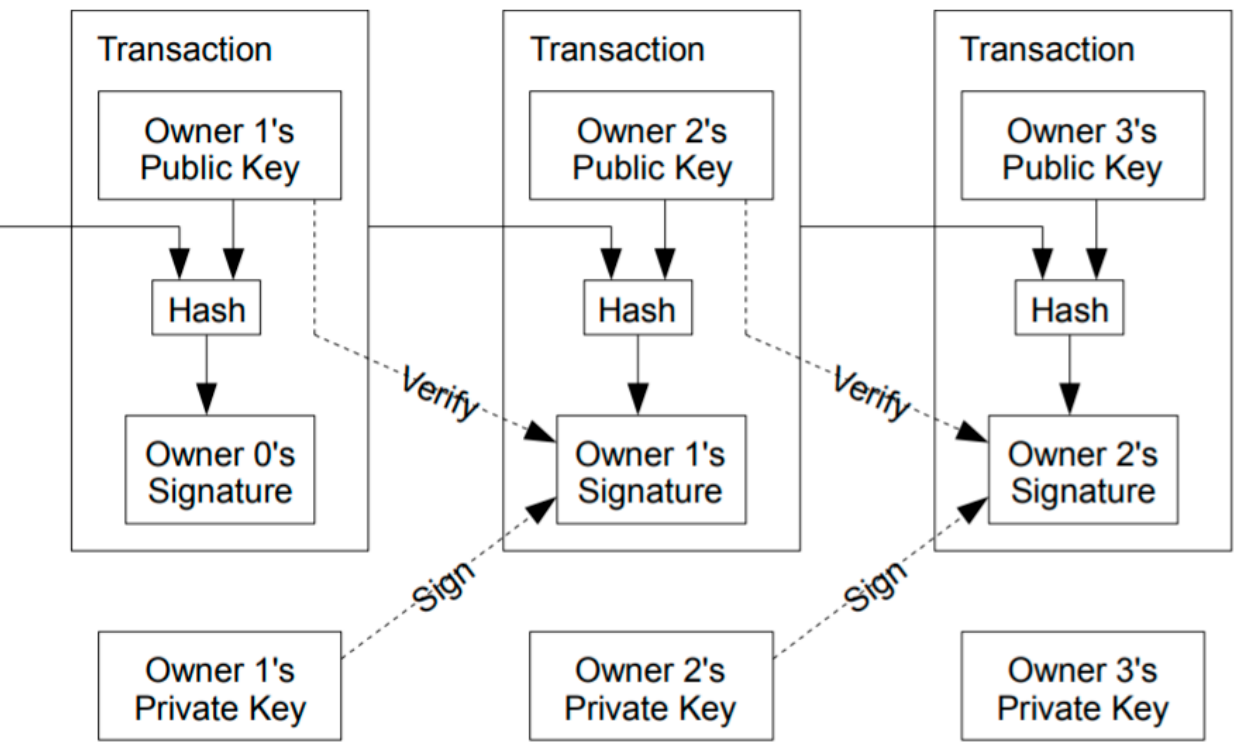
Figure 5. The Algorithm Structure of Bitcoin Consensus Algorithm (Source: Bitcoin Peer to peer system 2008).